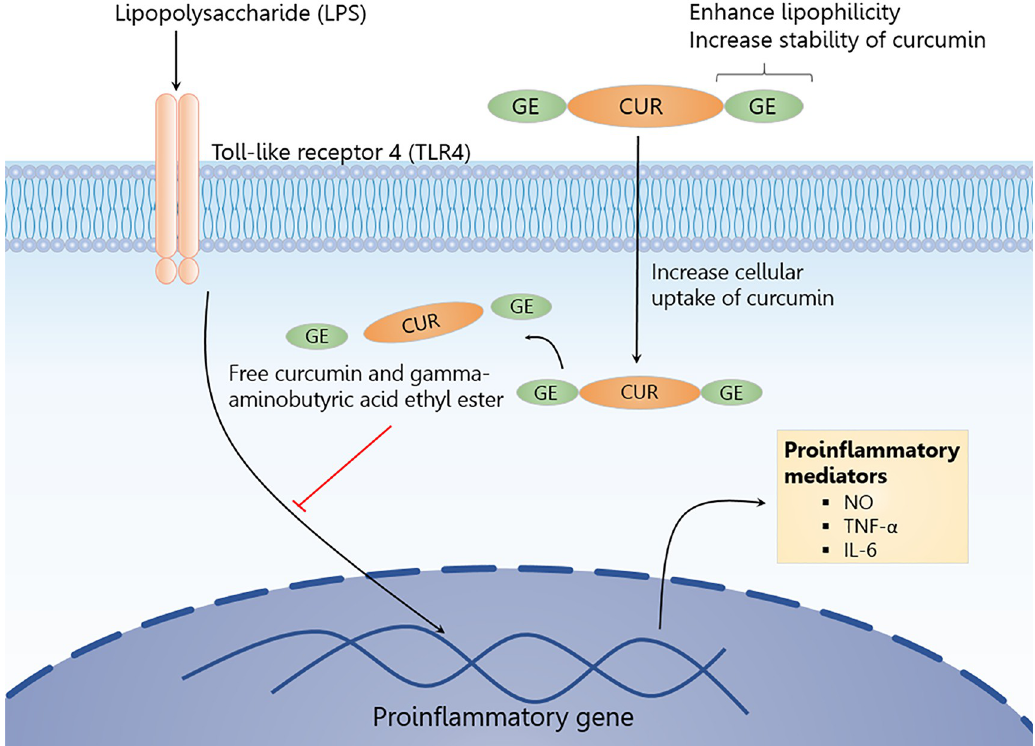
Fig 10. Proposed mechanism of CUR-2GE in LPS-stimulated BV-2 microglial cells. CUR-2GE with improved stability and lipophilicity profiles enhanced cellular uptake of curcumin, leading to greater anti-inflammatory effects in LPS-stimulated BV-2 cells. CUR, curcumin; GE, gamma-aminobutyric acid ethyl ester; IL-6, interleukin 6; LPS, lipopolysaccharide; NO, nitric oxide; TNF- α , tumor necrosis factor α .